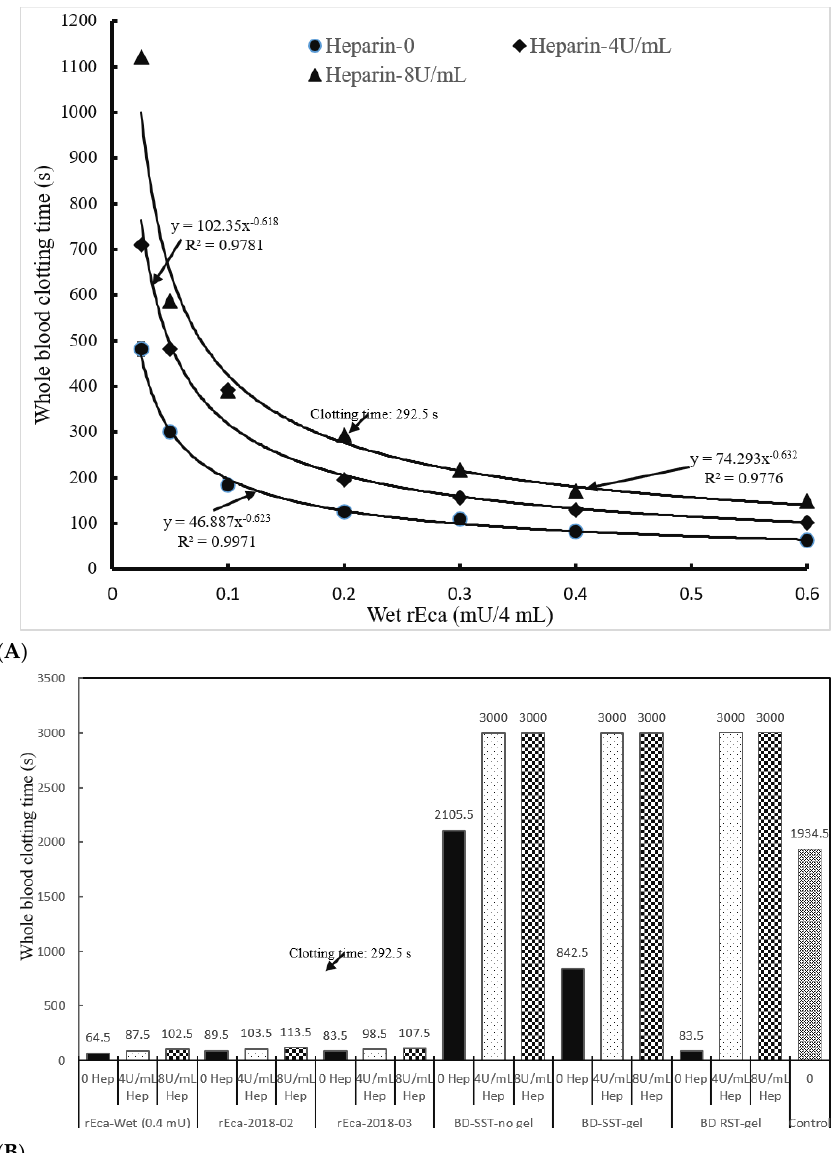
Figure 3 . Potential of rEcarin as an additive in blood collection tubes for clotting heparinized blood. Both wet and dried rEcarins effectively clot recalcified citrated whole blood with or without heparin . ( A ) Standard curves of wet rEcarin in a GBO white top plain tube efficiently clots recalcified citrated whole blood spiked with two doses of heparin (4 and 8 U/mL heparin) and without heparin. ( B ) rEcarin (0.4 mU/tube) dried in a GBO white top plain tube efficiently clots the recalcified citrated whole blood spiked with two doses of heparin (4 and 8 U/mL heparin), compared with that of three commercial blood collection tubes (BDSST-no Gel, BDSST with gel, and BD RST tube). To confirm the visual blood clotting results, a TEG assay was conducted. Results showed that heparinized blood (8 U/mL) in a BDRST tube had an R time of 5700 s without any clotting and none of the other three clotting parameters (K time, angle- α and MA value) gave measurable data. V curve analysis supported that the heparinized blood in a